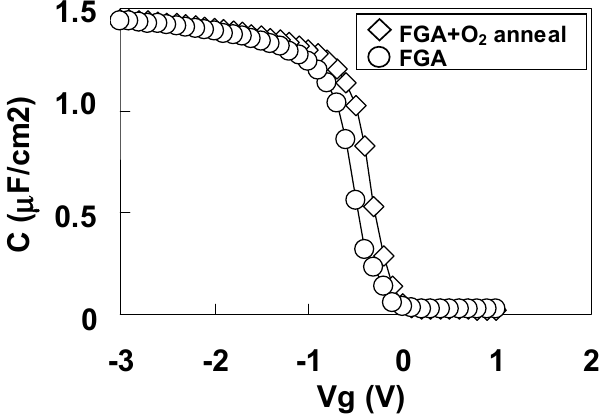
FGA only and after additional O